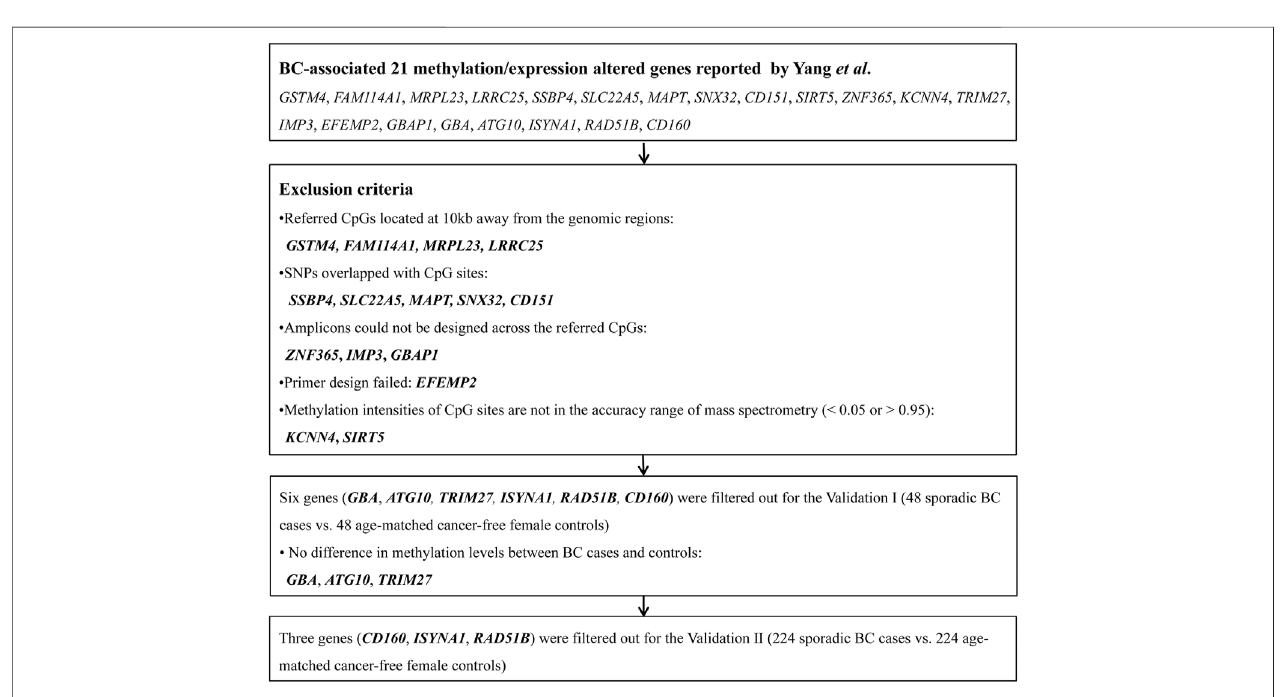
FIGURE 1 | Work- fl ow for the selection of methylated genes. The fl owchart shows the steps to fi lter out the altered DNA methylation markers for the validation via mass spectrometry in the Chinese population.